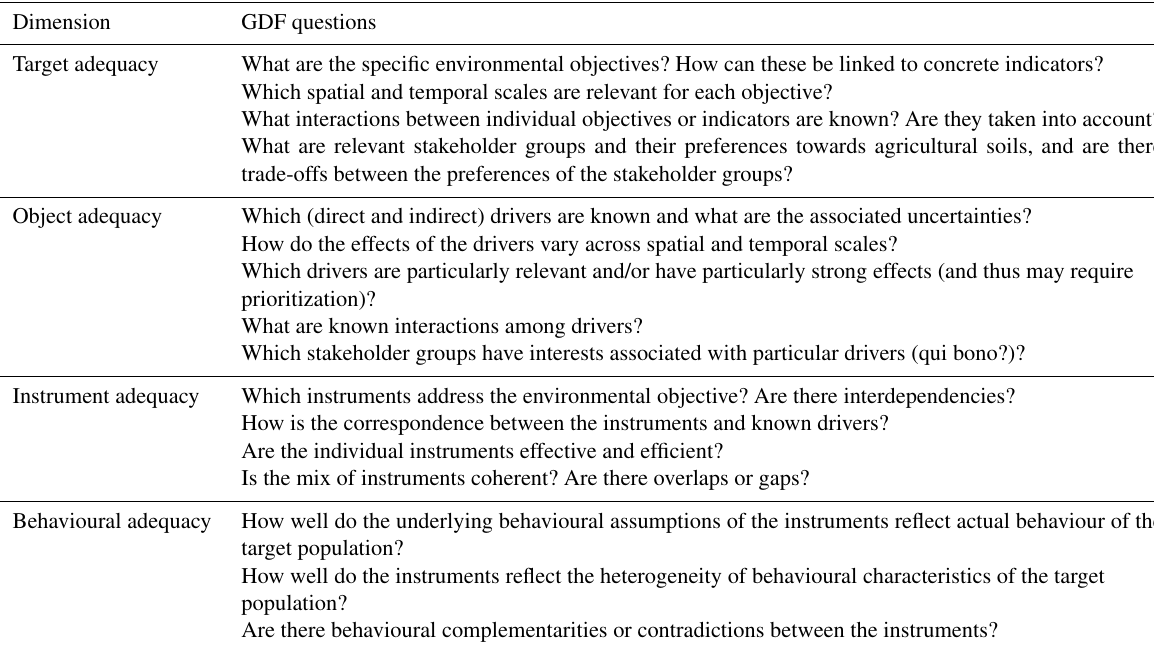
Table 1. Research questions for the explorative application of the governance disruptions framework to agricultural soil governance in